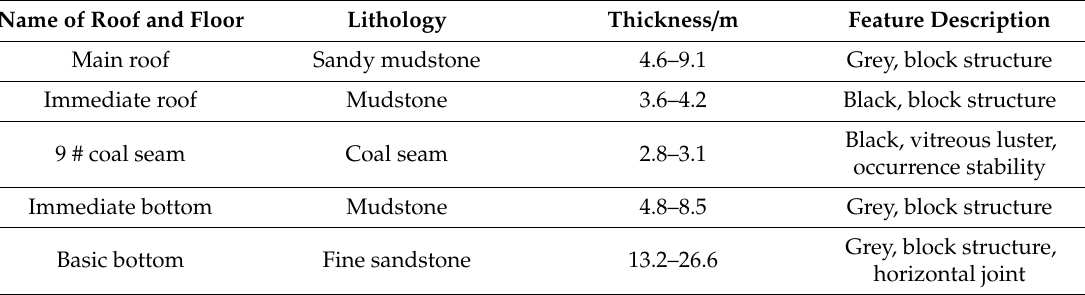
Table 1. Lithological characteristics of roof and floor of coal